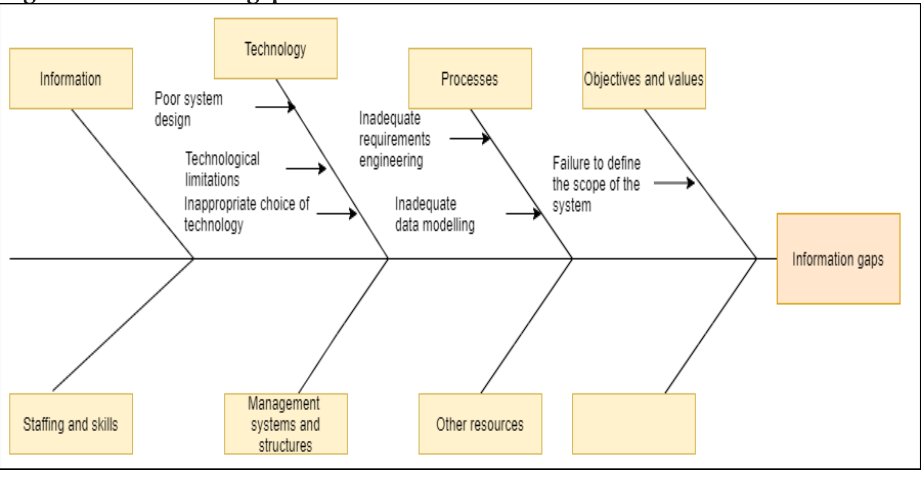
Figure 16: Information gaps